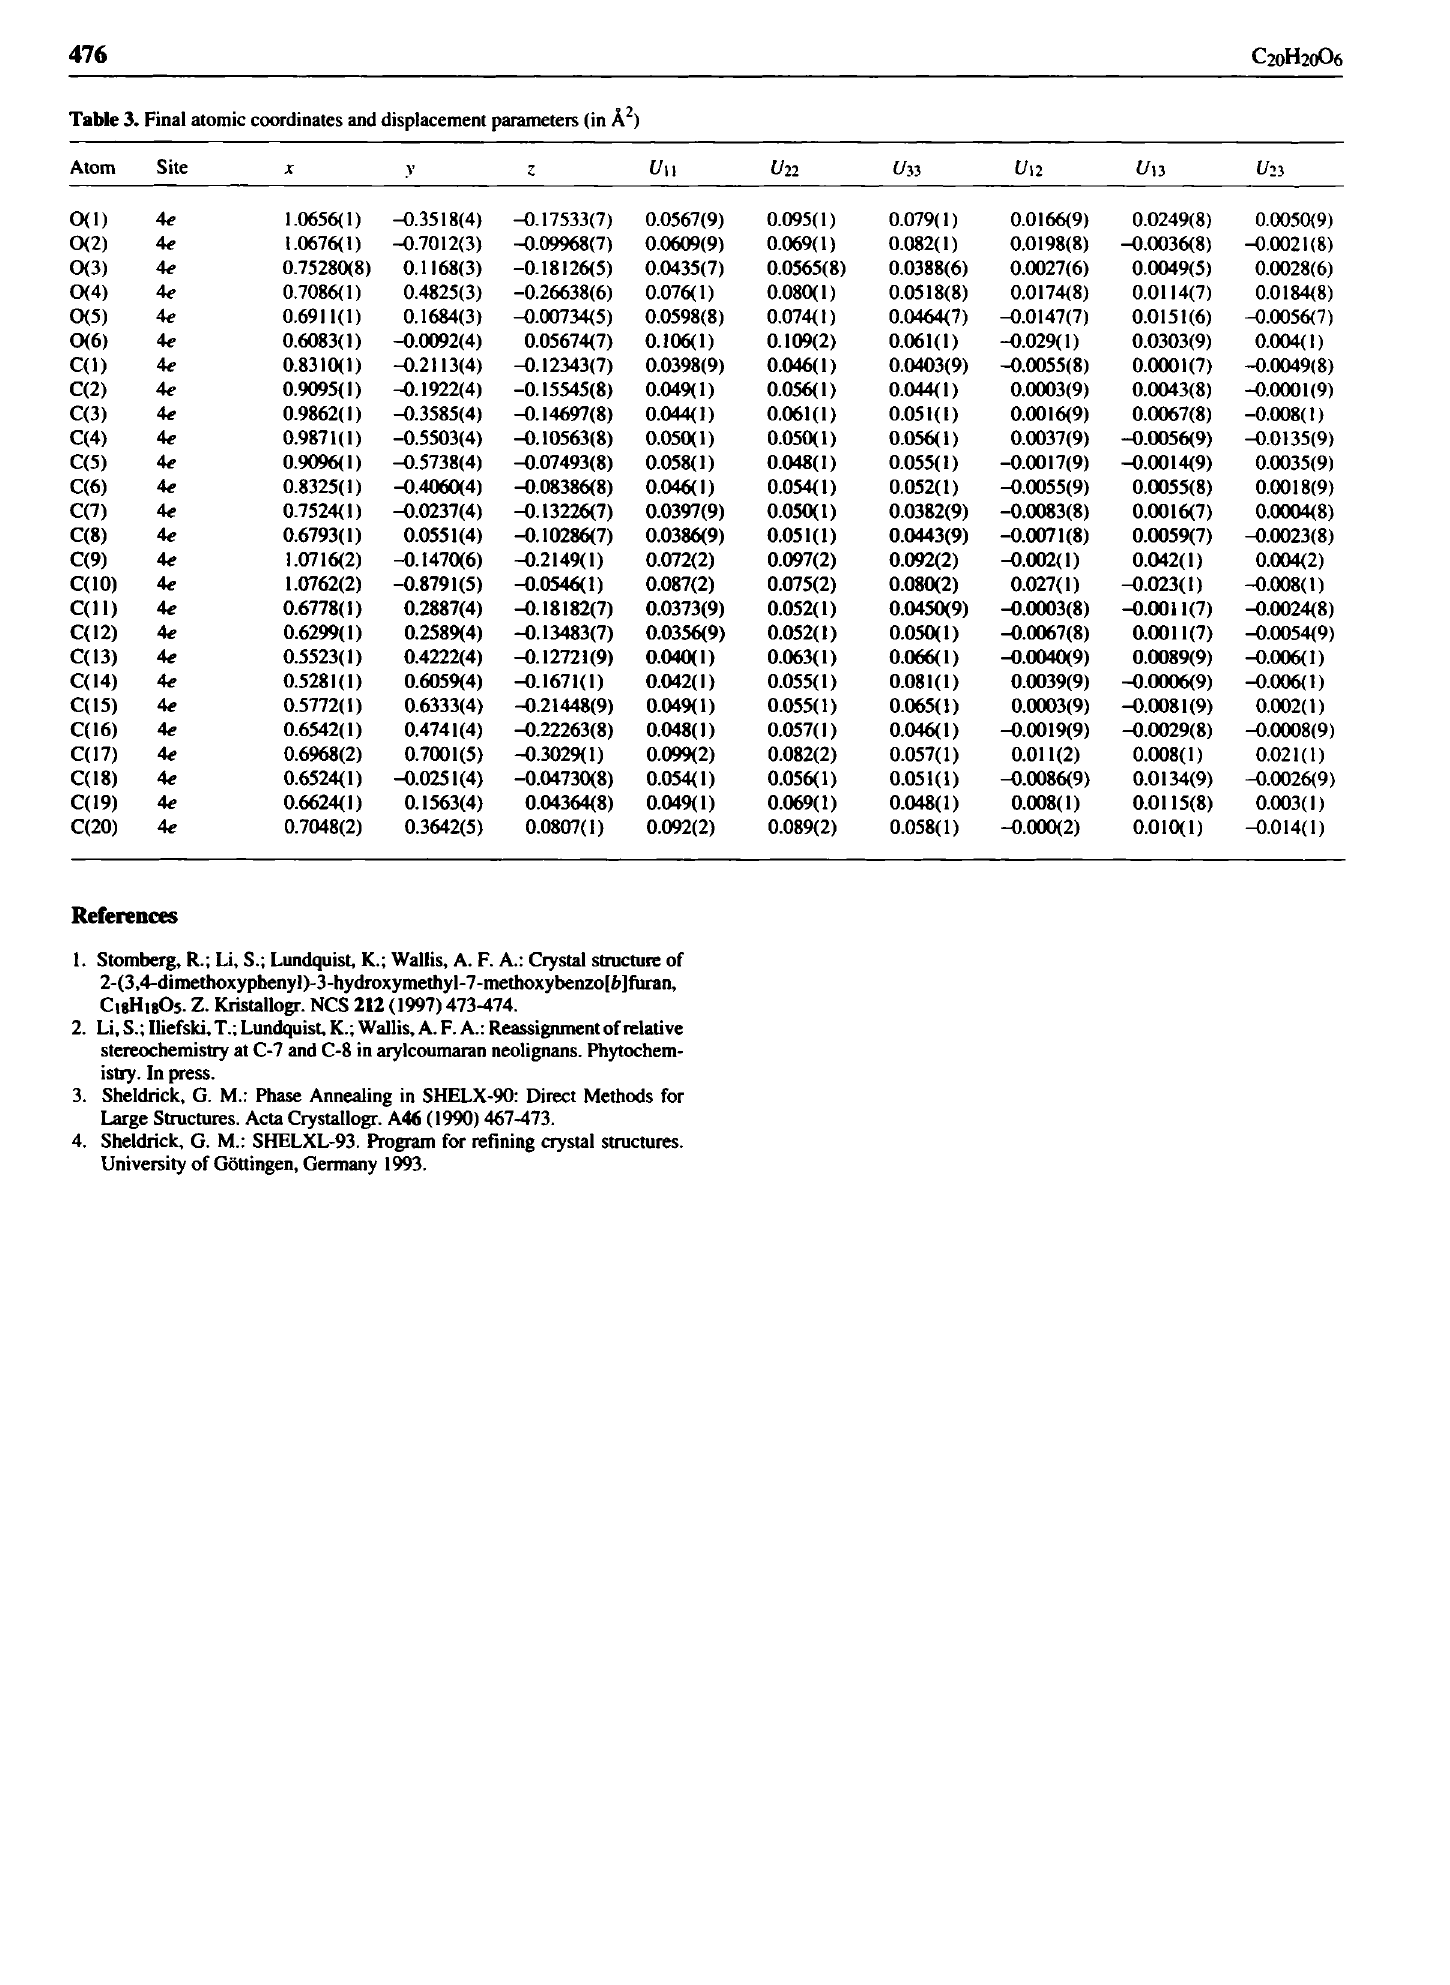
Table 3. Final atomic coordinates and displacement parameters (in Ä 2